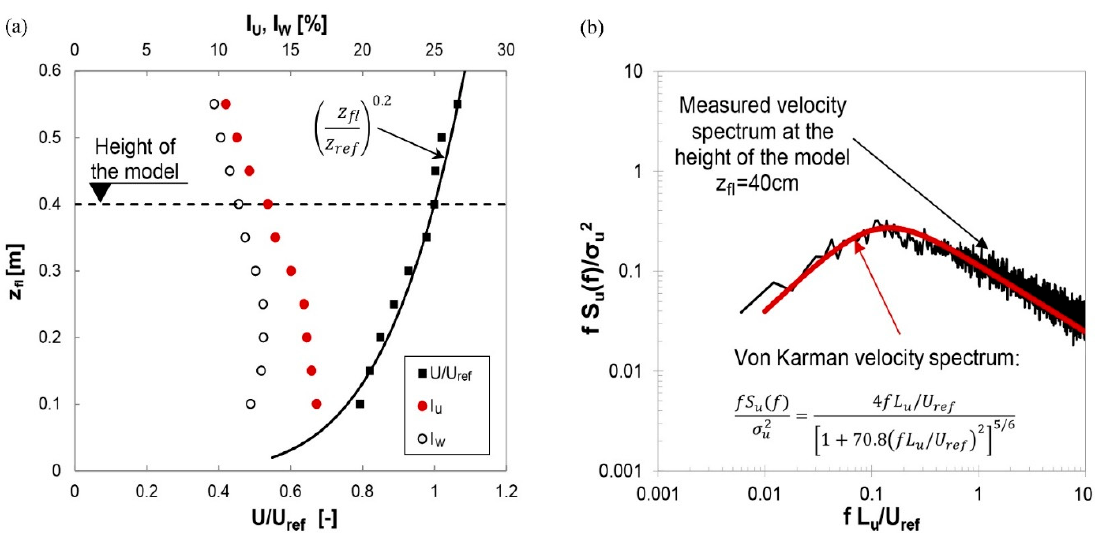
Figure 3. ( a ) Mean stream-wise wind speed ( U/U ref ), stream-wise turbulence intensity ( I U ) and vertical turbulence intensity ( I W ) profiles, measured from the floor of the wind tunnel ( U ref is the mean wind speed at the model height), ( b ) longitudinal velocity spectrum at the height of the model.